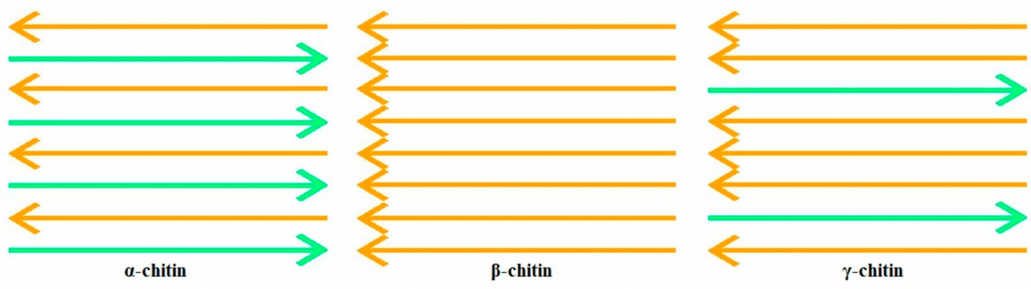
Figure 1. Schematic representation of the three polymorphic forms of chitin.